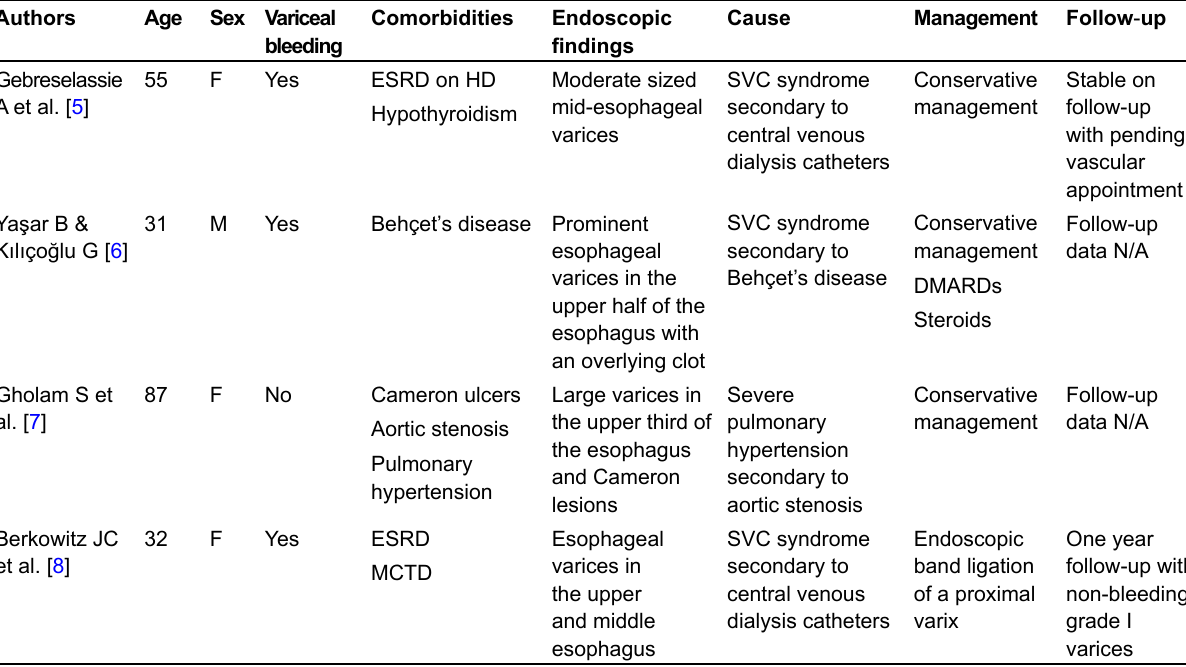
Figure 3. PRISMA flowsheet for data selection Table 1. Demographics, presentation, causes and management of patients with downhill